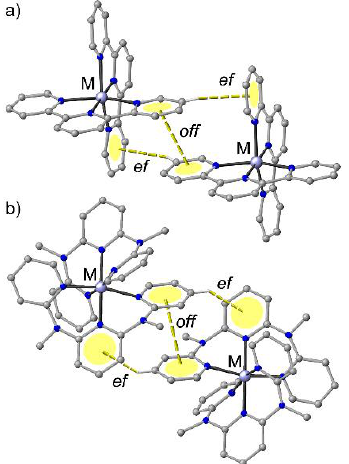
Figure 2. General motifs of phenyl embraces of ( a ) [M(tpy) 2 ] 2+ and ( b ) [M(ddpd) 2 ] 2+ complexes.